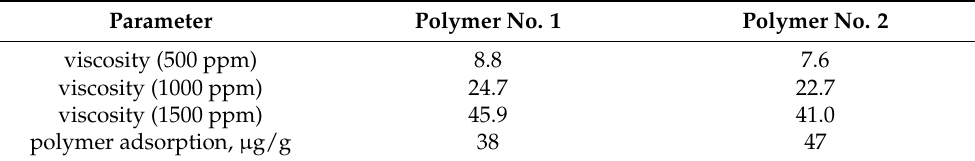
Table 2. Comparison of laboratory studies on the selection of polymer grade for polymer flooding.